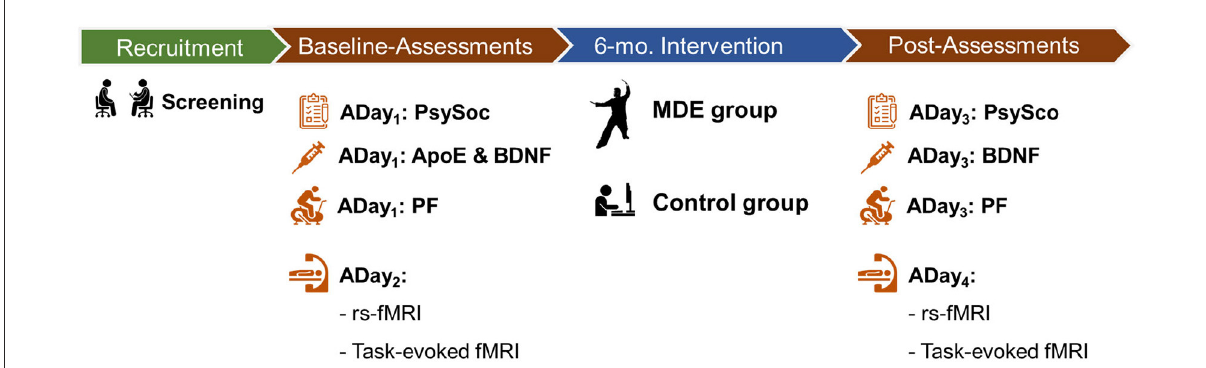
FIGURE3 Experimental timeline. ADay 1 , ADay 2 , ADay 3 , and ADay 4 , assessment day 1 to assessment day 4, respectively; BDNF, brain-derived neurotrophic factor; fMRI, functional magnetic resonance imaging; MDE, multi-domain exercise; PF, physical fitness assessments; PsySoc, psychosocial measures; rs-fMRI, resting-state functional magnetic resonance